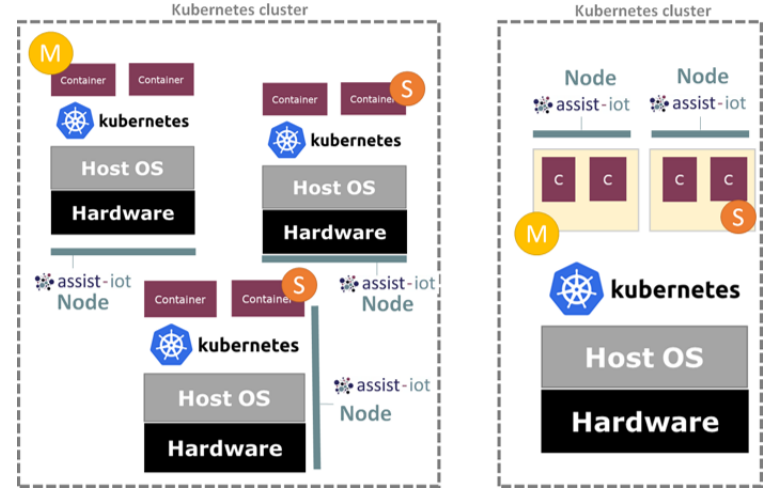
Figure 13. ASSIST-IoT hardware-software relationship overview. CPU